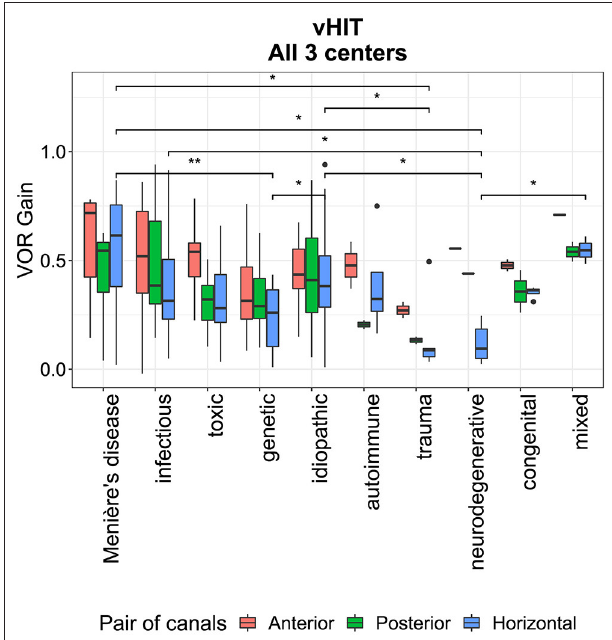
FIGURE 8 | Vestibular Ocular Reflex (VOR) gain per etiology for all three pairs of semi-circular canals (i.e., horizontal, anterior, and posterior canals) measured with video Head Impulse Test, presented for all three centers combined. Each box plot represents the 25–75 percentiles, bold black lines the median, dots the outliers and asterisks (*) illustrate statistically significant